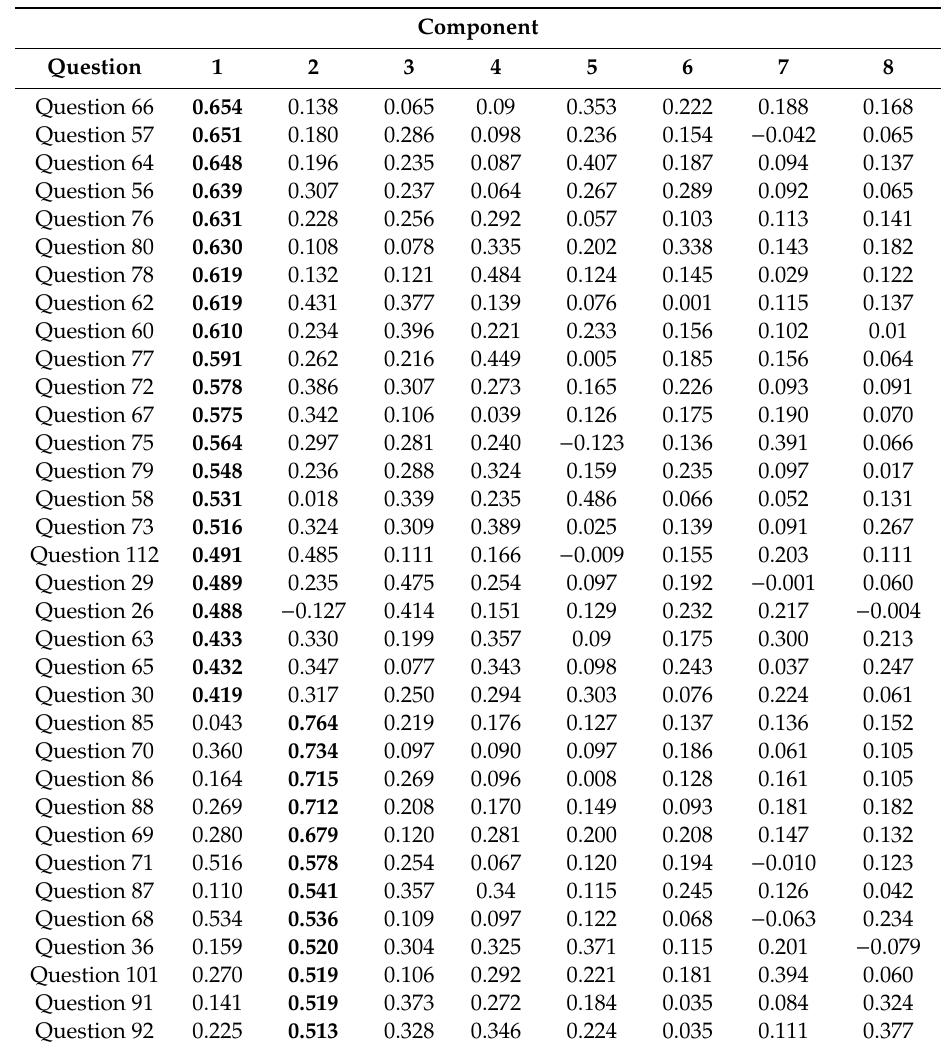
Table A2. Rotated component